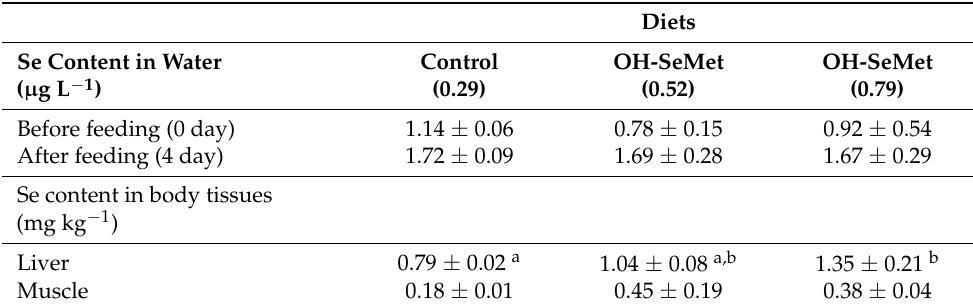
Table 4. Selenium content in tank water ( µ g L − 1 ) and body tissues (mg kg − 1 ) of gilthead seabream after 13 weeks of feeding diets with different supplementation of